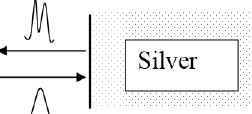
Figure 4. Schematic diagram for a Gaussian polychromatic wave incident on an air-silver interface and its modified reflected spectral distribution. The reflected spectrum I ( r ) (λ) is